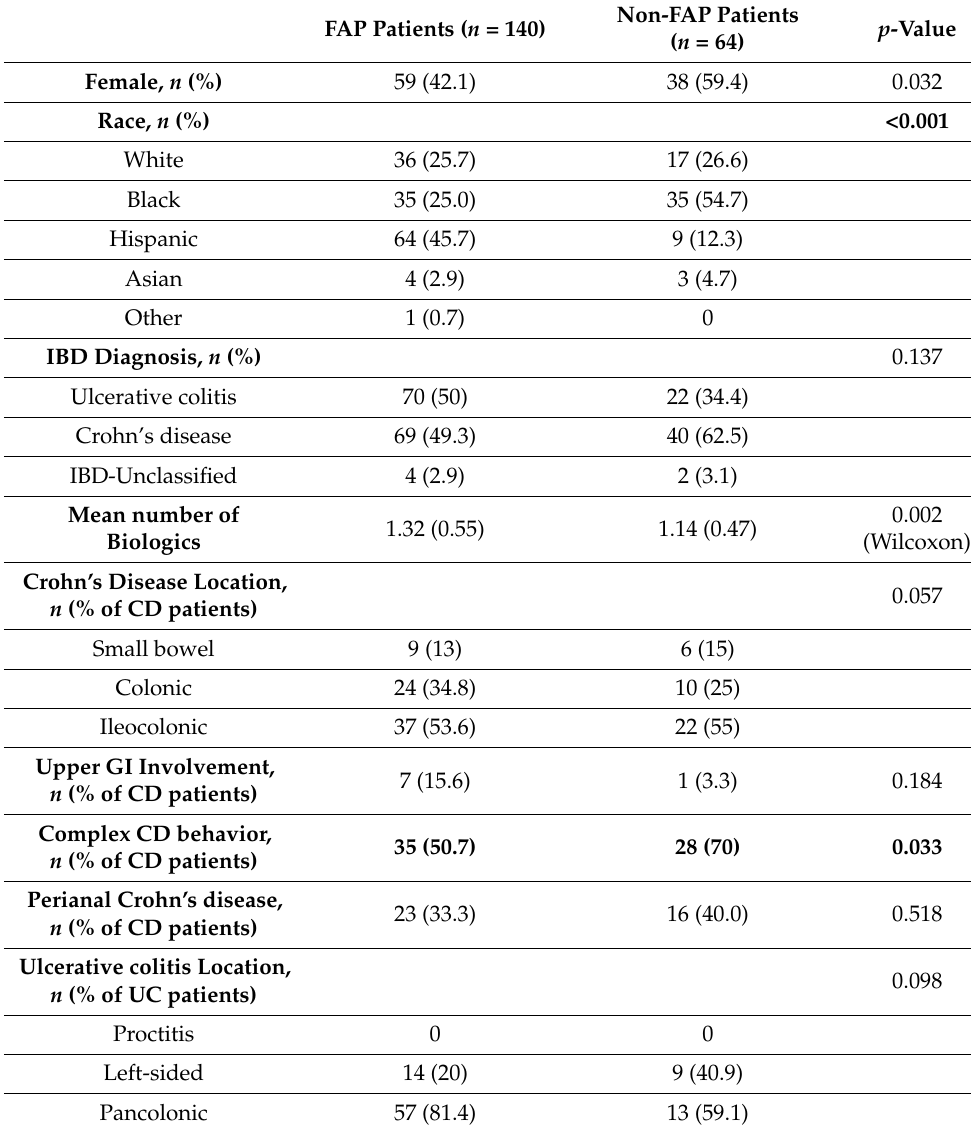
Table 2. Cohort demographics and differences among IBD patients with and without financial assistance program ( n = number of unique